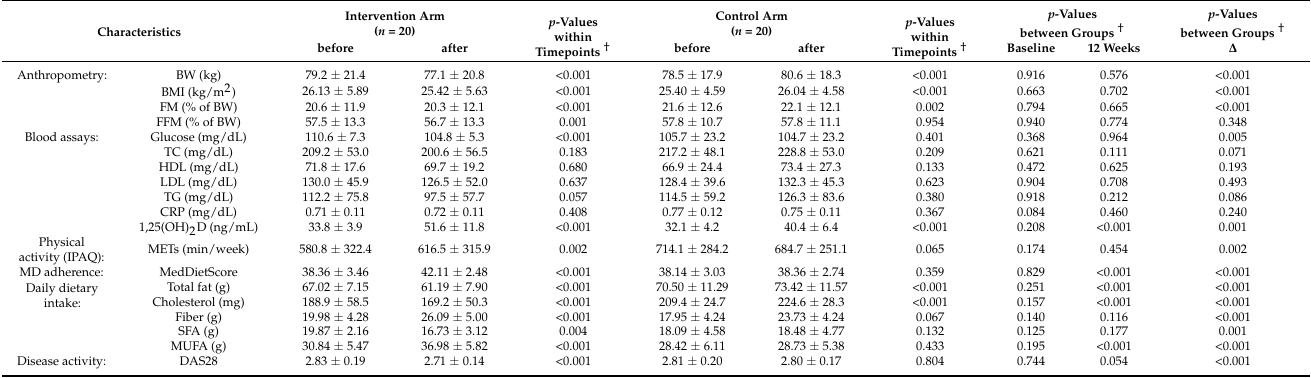
Table 3. Characteristics of the participating women at baseline and end of treatment (12 weeks)